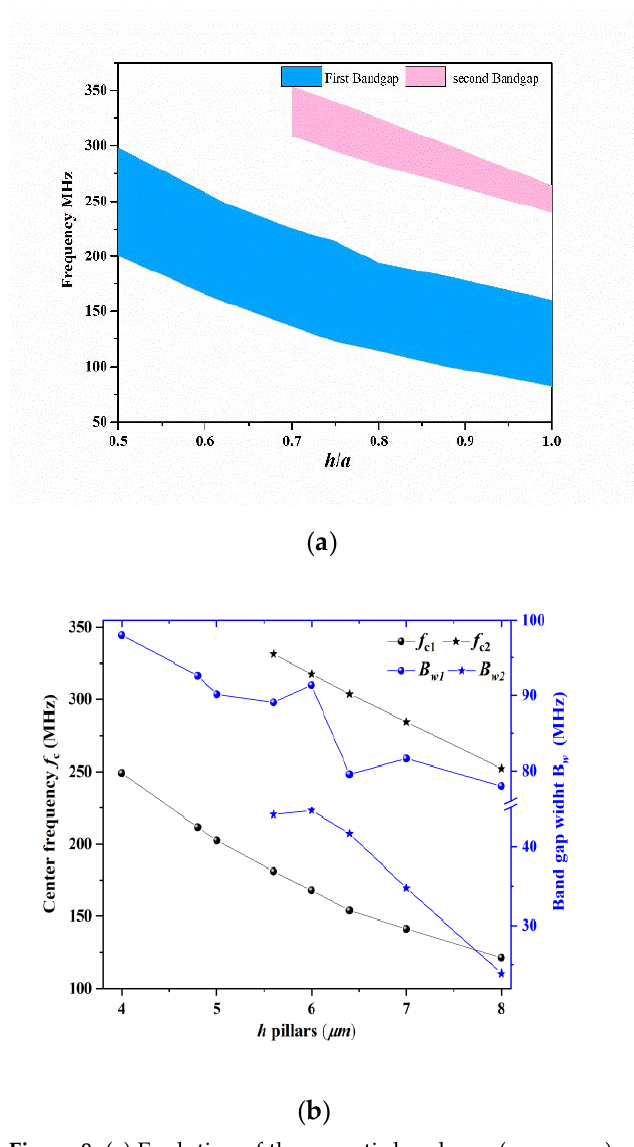
Figure 8. ( a ) Evolution of the acoustic bandgaps (gaps map) as a function of the aspect ratio ( h / a ). ( b ) Evolution of the center frequency f c and the bandgap width B w of the first and second bandgaps as a function of the height of the pillars of radius r = 2.6 µm.